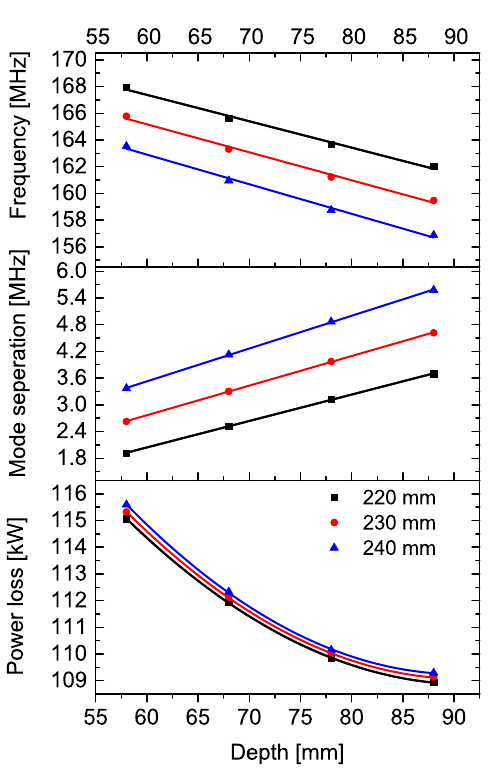
FIG. 9. Evaluation of TE 210 , mode separation between TE 210 and 0 TE 110 , and power loss as a function of the depth for three width values. The stored energy of the RFQ cavity remains 1 J during the